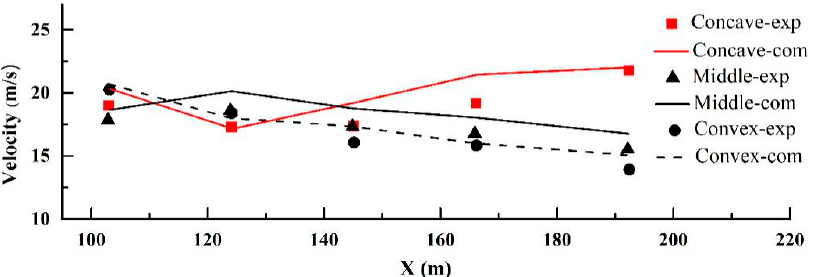
Figure 13. The water flow velocity obtained by experimental measurement and numerical simulation.